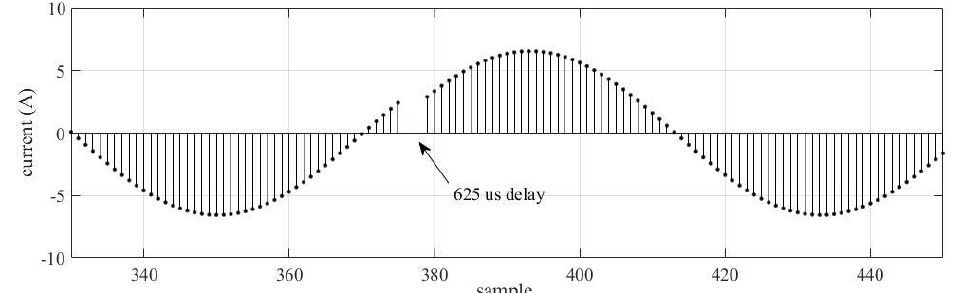
Figure 4. Current signal with packet delay.